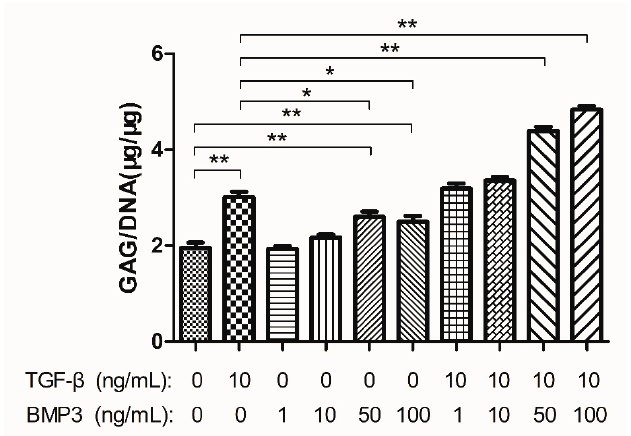
Figure 2. Glycosaminoglycan (GAG) synthesis normalized to DNA content of each group after cultured for 14 days. Data represent mean ± SD; * p < 0.05; ** p <